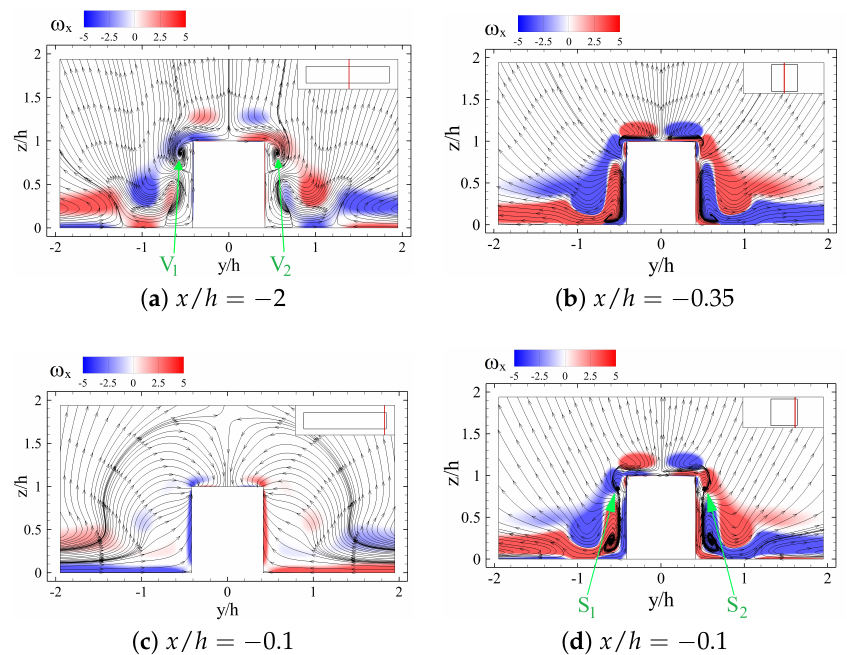
Figure 22. Mean streamlines on cross-sectional ( yz -) planes along the ( a , c ) long and ( b , d ) square